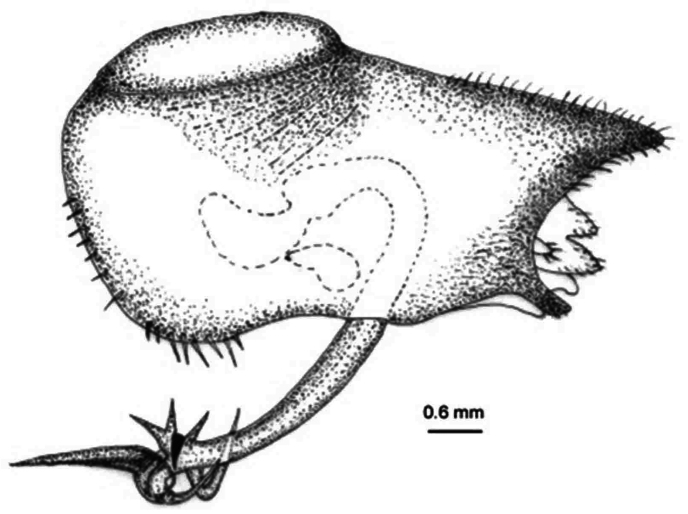
Cicadatra platyptera, pygofer (scale= 0.6 mm).